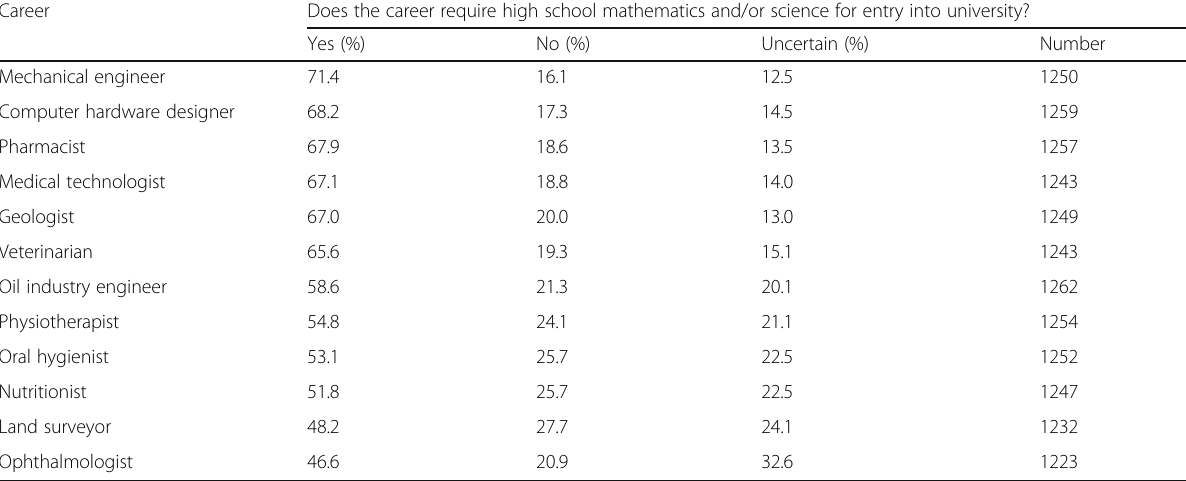
Table 1 Classification of careers as requiring mathematics and/or science by students in Atlantic Canada